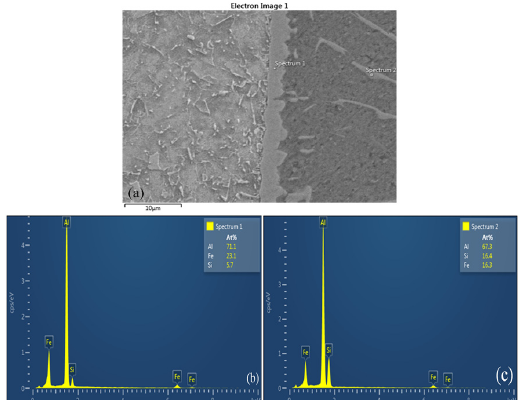
Figure 7. Energy dispersive X-ray spectrometer (EDS) analysis results of butt joint of A5052 aluminum alloy and SS400 steel: ( a ) Analysis positions; ( b ) Corresponding amounts at spectrum 1; ( c ) Corresponding amounts at spectrum 2.